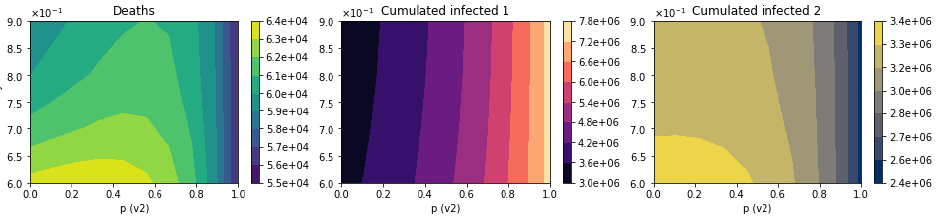
Figure 14. Total number of deaths and the cumulative number of infected people for each age group. This scenario considers a ratio r = 2. The factor that is varied is the efficacy of the vaccine.